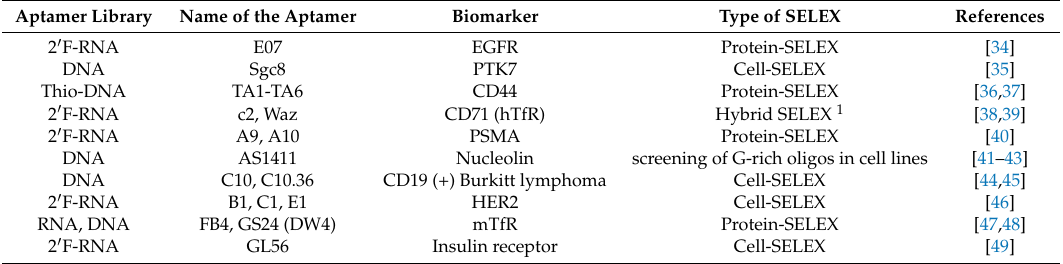
Table 1. Aptamers that bind cell-surface markers selected by protein-SELEX or cell-SELEX. Aptamer